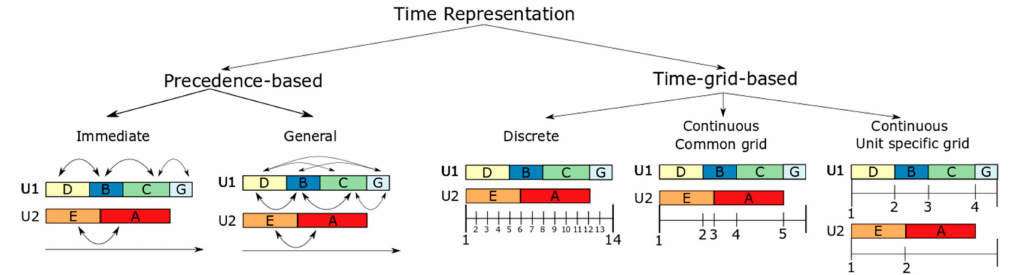
Figure 6. Categorization of modelling approaches based on time